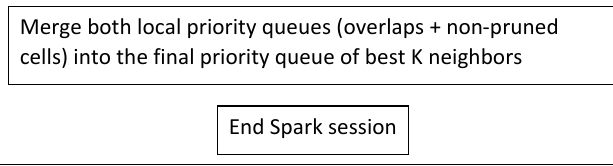
Figure 16. Create final list of neighbors (Phase